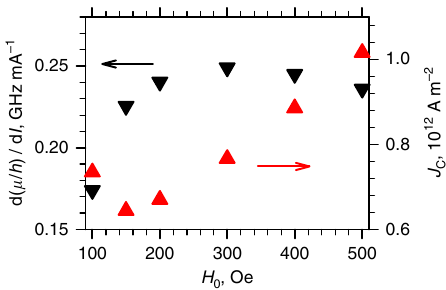
Fig. 5 Dependence on the magnetic fi eld. Static- fi eld dependences of d( μ / h )/d I , the ef fi ciency of spin current-driven chemical potential variation in frequency units (point-down triangles), and of J C , the critical current density in Pt at which the chemical potential is expected to reach the energy of the lowest magnon state